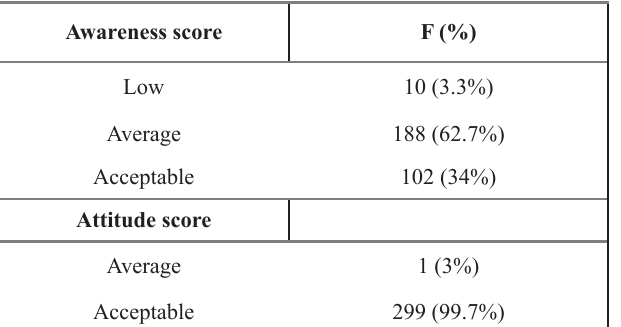
Table 1. Distribution of awareness of and attitude toward oral/dental hygiene of mothers referred to health centers